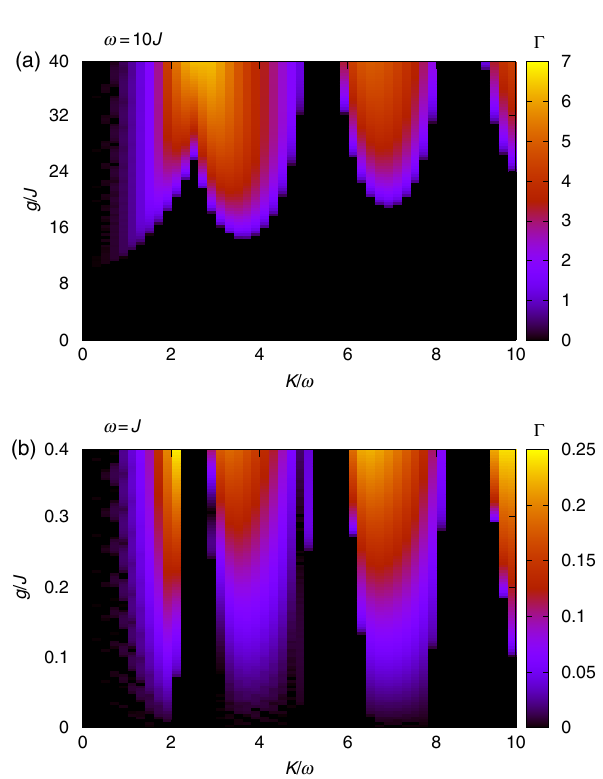
FIG. 3. Numerical instability rate Γ as a function of interaction strength g ¼ U ρ and modulation amplitude K= ω , for two values of the driving frequency ( ω ¼ 10 J and ω ¼ J ). At large ω (i.e., outside the “ low-frequency ” regime, see text), the instability rates depend mostly only on K= ω and g= ω 2 , while in the low- frequency regime, instabilities can occur at infinitesimal inter- action